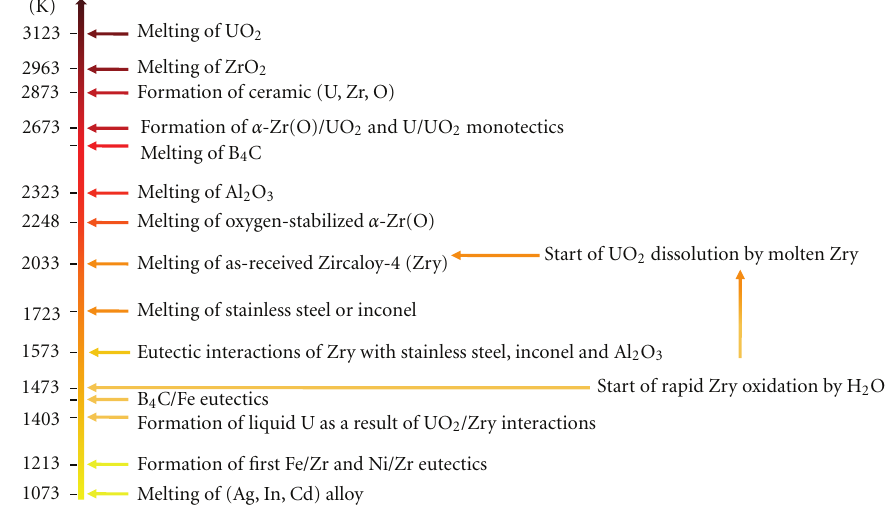
Figure 2: Progression of core